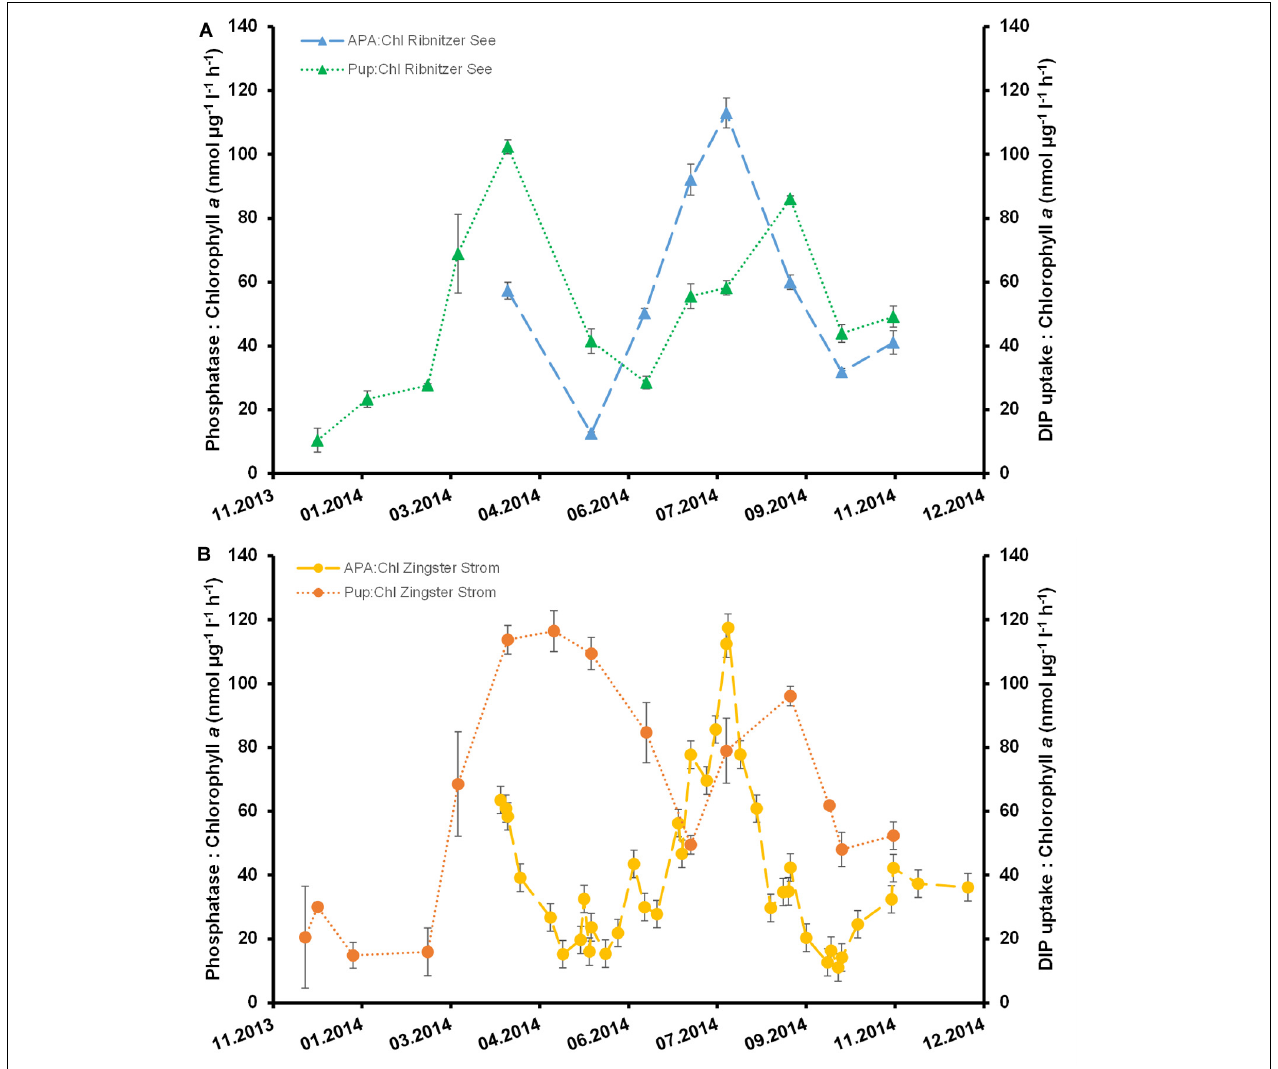
FIGURE 5 | Phosphatase activity normalized to chlorophyll a (nmol µ g − 1 l − 1 h − 1 ) and dissolved inorganic phosphate uptake of the first hour normalized to chlorophyll a (nmol µ g − 1 l − 1 h − 1 ) for the Ribnitzer See (A) and in the Zingster Strom (B) . Error bars represent the combined standard deviation from measuring replicates of phosphatase activity ( n = 3), DIP uptake ( n = 3), and Chl a ( n =